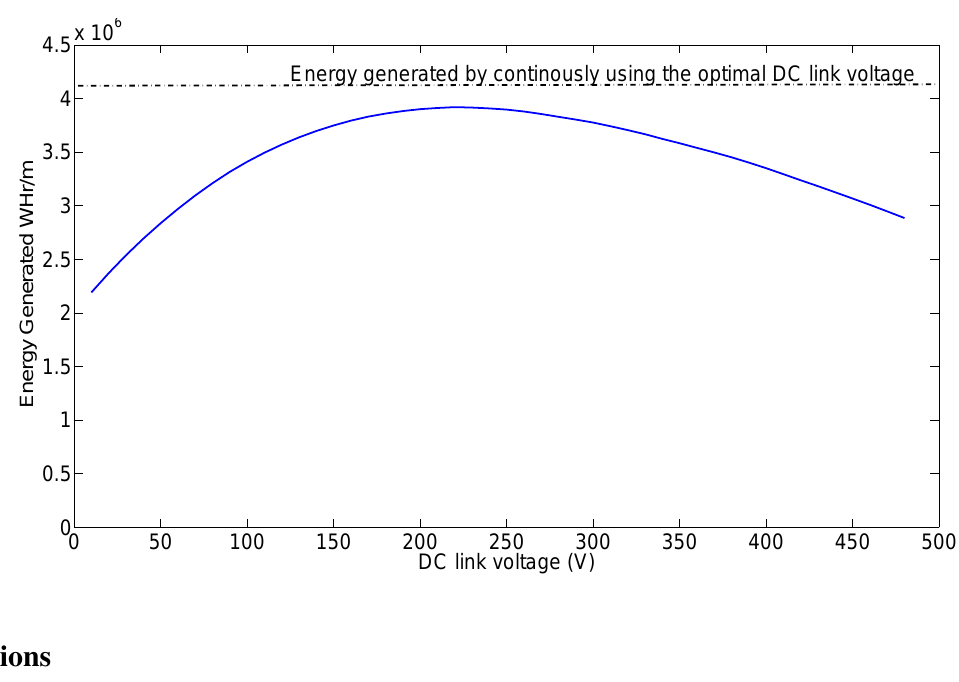
Figure 10. Annual energy variation with different constant DC